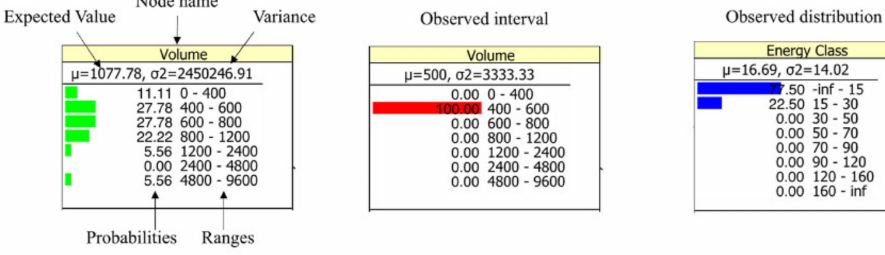
Figure 12. The legend of the node monitor windows of the following